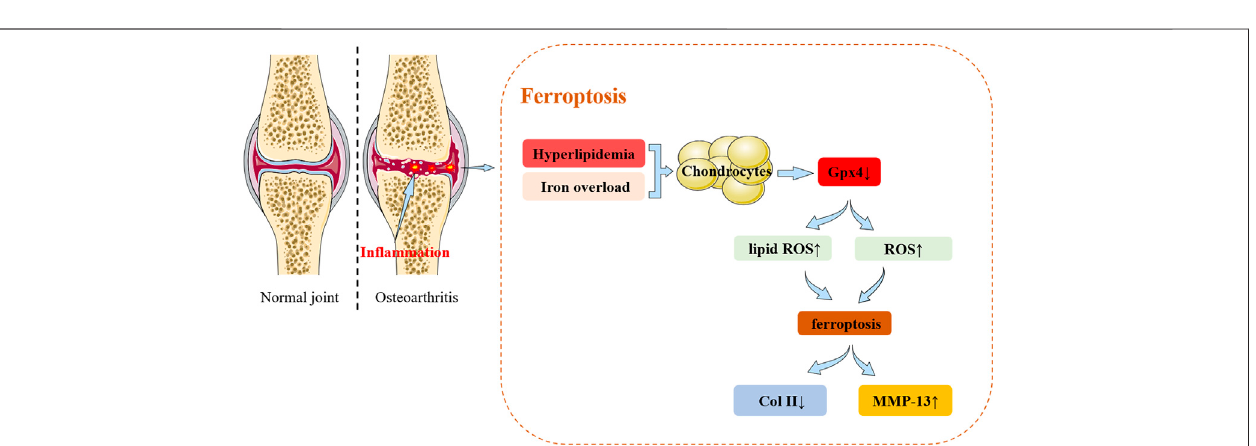
FIGURE 2 | The relationship between ferroptosis and osteoarthritis (OA). Ferroptosis: In cellular environments stimulated by iron overload, hyperlipidemia, in fl ammation, the expression of Gpx4 in chondrocytes decreases. These changes lead to the accumulation of reactive oxygen species and lipid peroxides to ultimately induce ferroptosis. Ferroptosis in turn can progressively exacerbate the in fl ammatory response leading to the increased expression of MMP-13 and decreased expression of collagen II in chondrocytes to accelerate the progression of OA.